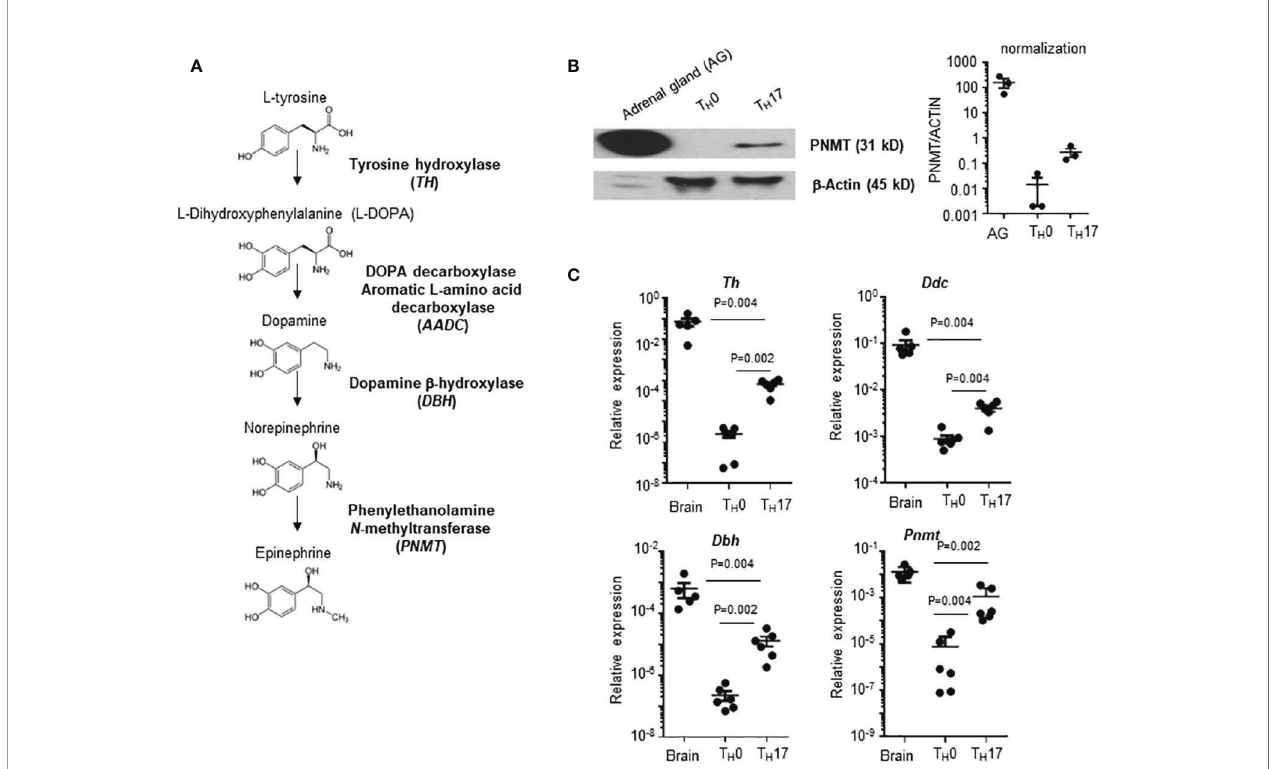
FIGURE 1 | PNMT expression in T H 17 cells. (A) Diagram of de novo epinephrine synthesis and converting enzymes. (B) PNMT expression in T H 17 cells. Naïve CD4+ T cells from spleens were isolated and T H 0 or T H 17 cells were differentiated. Lysates of each cell subset (20 m g each) and adrenal gland tissue lysates (1 m g) were used for western blotting. Expression of actin was detected as a control protein. One representative image from 3 independent experiments. Graph is a quantitation and normalization of PNMT to ACTIN. (C) Total RNA was prepared and levels of Th , Ddc , Dbh , and Pnmt mRNA was measured by qPCR. RNA samples from the mouse brain (control mice) were used as positive controls. Relative expression was normalized to the level of Actin. Each dot represents an individual sample and the bar represent mean ± SEM (n =